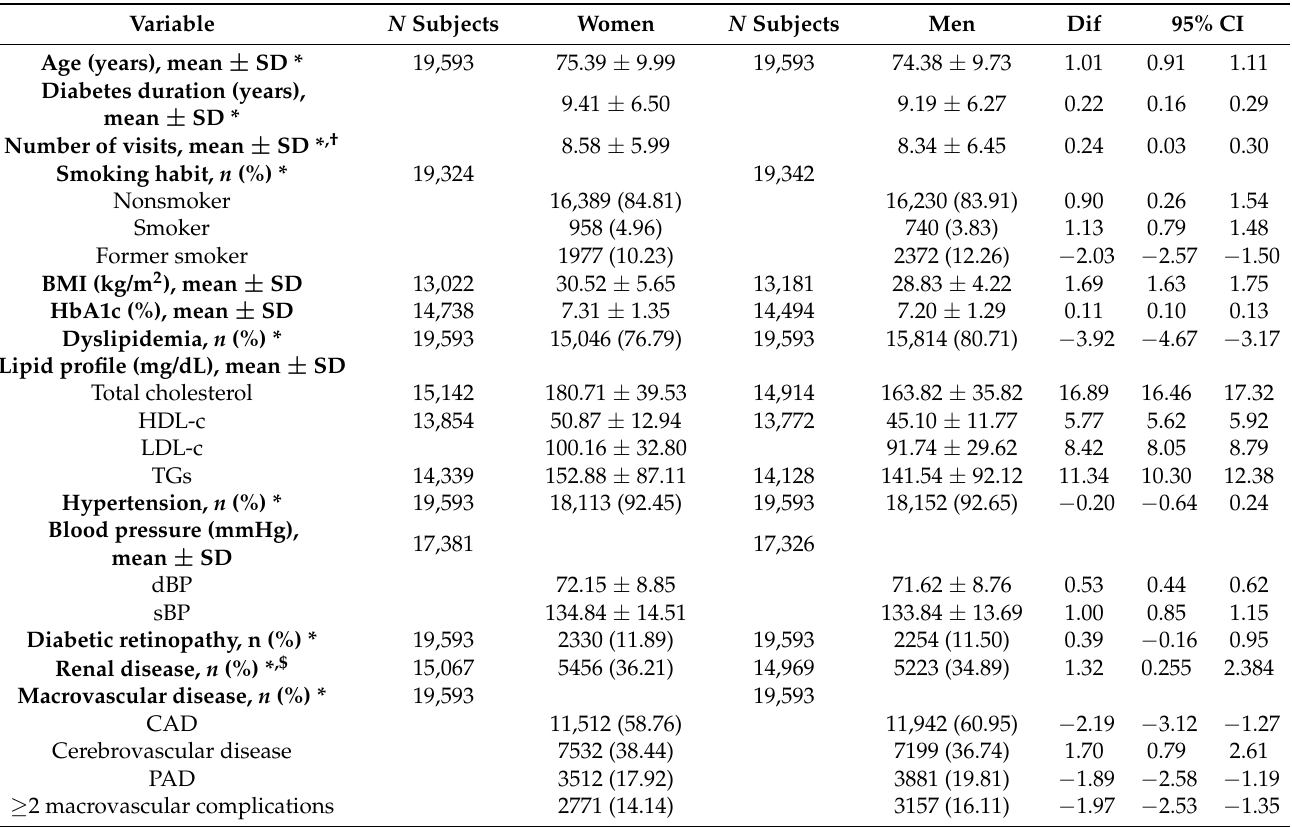
Table 3. Baseline characteristics of matched women and men with T2DM in secondary prevention by